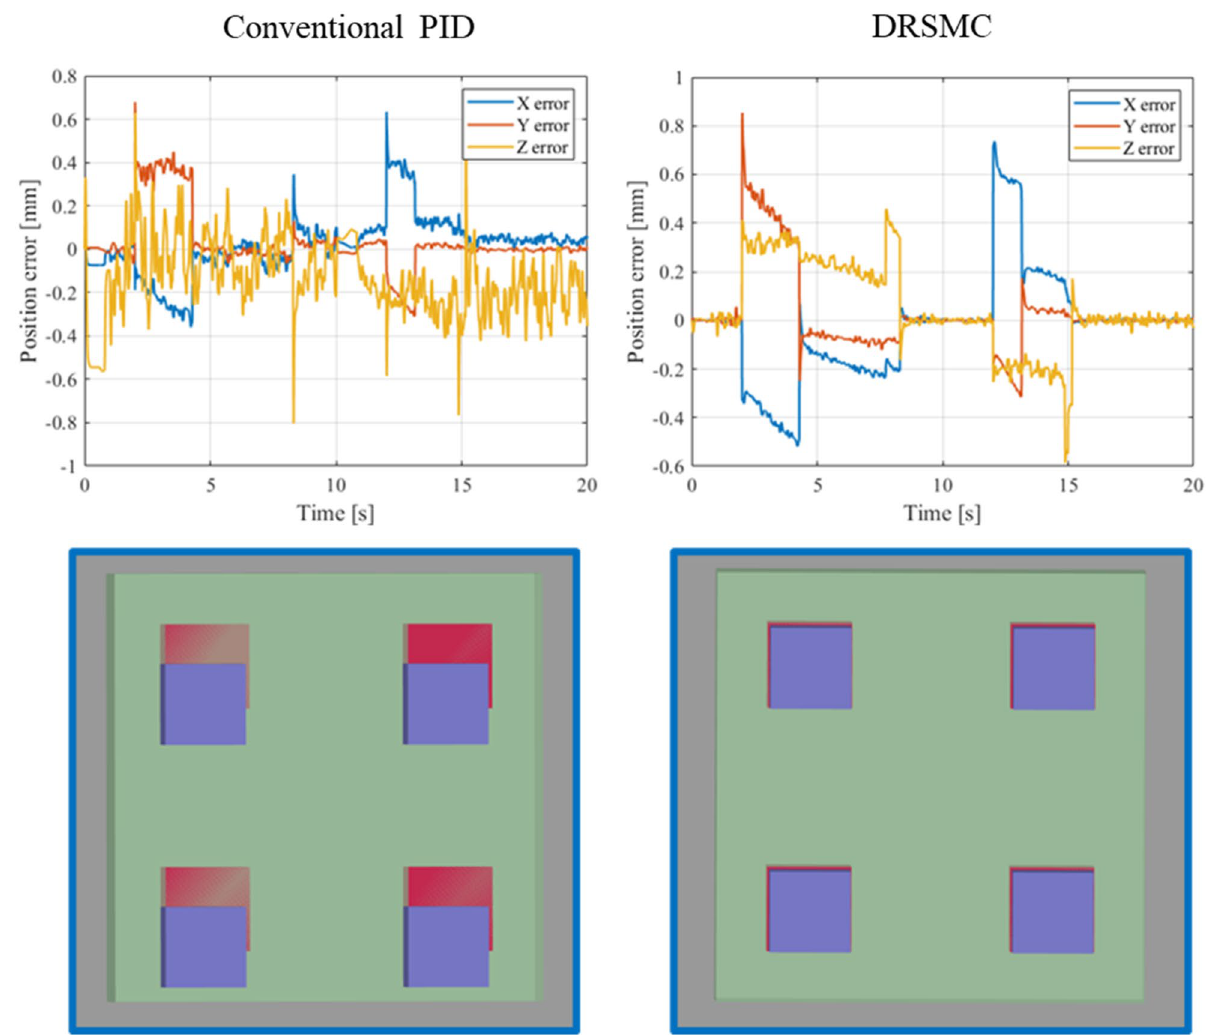
Figure 11. The tracking errors of manipulating point (top row) and the stable states after positioning (bottom row). The left column shows the performance using the conventional robot controller and the right column shows the performance under our